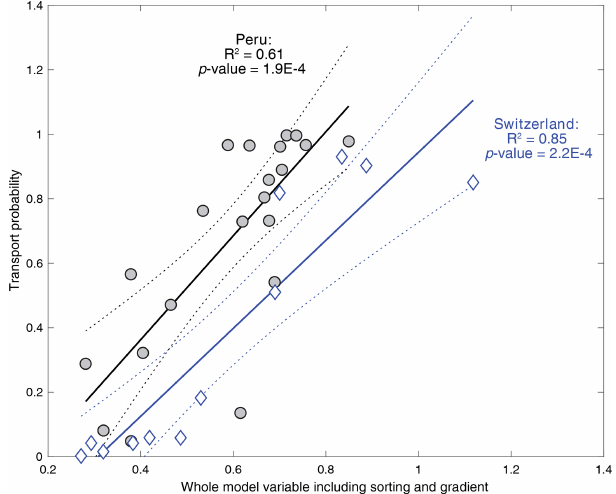
Figure 5. Transport probability for the Swiss and Peruvian rivers plotted as a function of the combined response to gradient and sorting. Blue diamonds correspond to the Swiss rivers, while grey circles are Peruvian ones. Both best multiple linear regression fits (solid line) and their 95% confidence intervals (dashed curves) are presented. Note that the variables on the axis are adjusted as a result of projecting the multiple linear regression models onto a bivariate